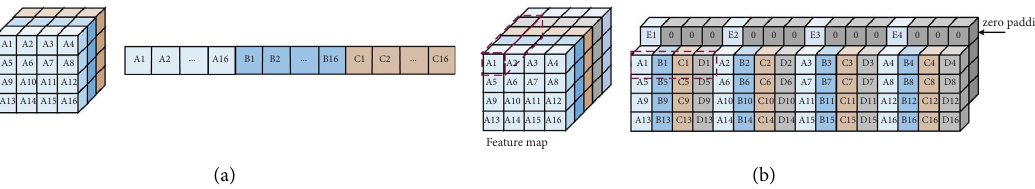
Figure 4: Data arrangement mode. (a) Te traditional memory arrangement mode. (b) Te novel data arrangement